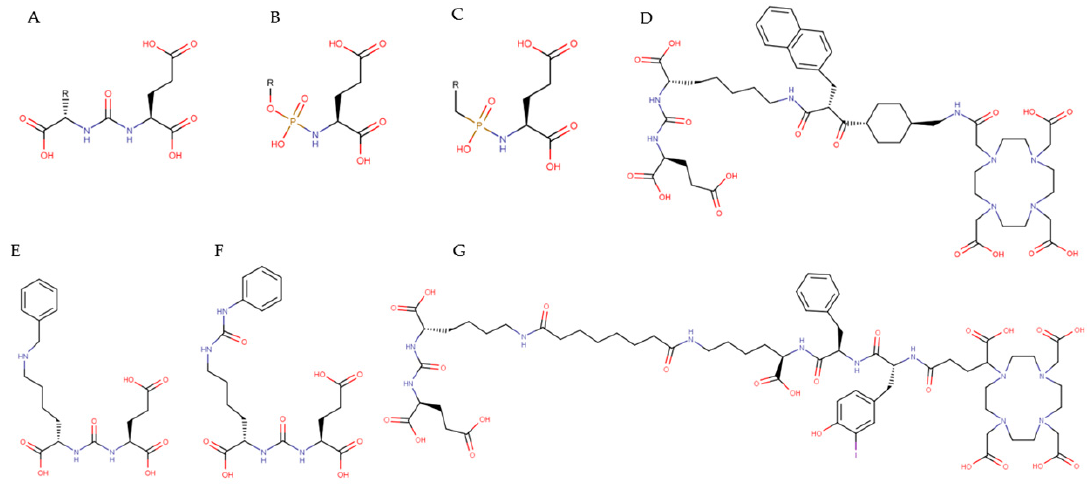
Figure 3. Chemical structure of selected PSMA-targeted small-molecule inhibitors. ( A ) urea-based compounds, ( B ) glutamatephosphoramidates, ( C ) 2-(phosphinylmethyl)pentanedioic acids, ( D ) PSMA-617, ( E ) MIP-1072, ( F ) MIP-1095, ( G ) PSMA I&T.